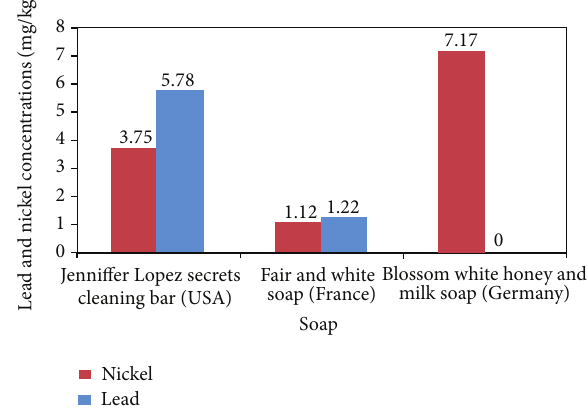
Figure 4: Lead and nickel concentrations (mg/kg) in soap. Sug- gested safe levels of Gondal et al. (0.5 ppm), Expert Panel 2007 (0.2 ppm), and Germany (1ppm). Suggested safe levels of nickel: Gondal et al. (5ppm), Basketter et al. low limit level (1ppm), and Basketter et al. high limit level (5ppm).